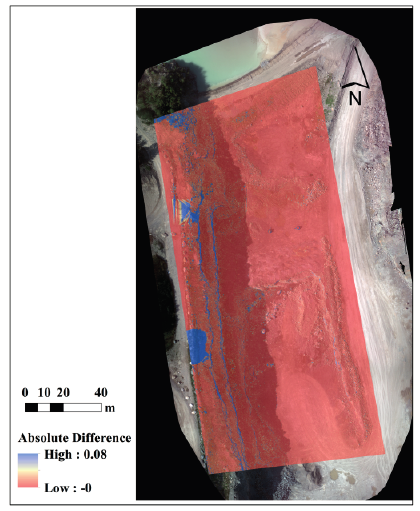
Figure 22. Absolute difference between the DSMs of dataset B before and after shadow